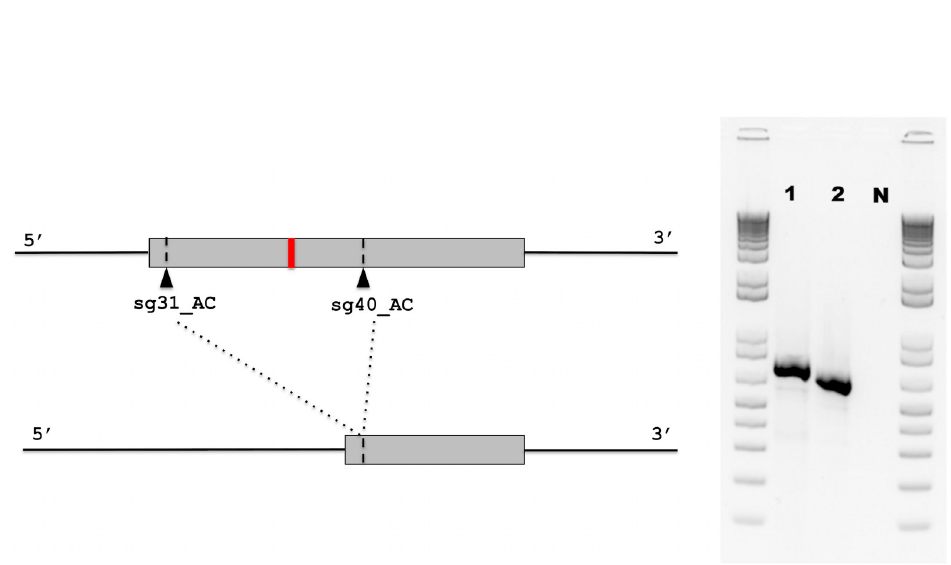
Fig 10. CRISPR Cas9 guide RNA design. Position of selected guide RNA in the second exon of SYNGR2 relative to the SYNGR2 p . Arg63Cys polymorphism resulting in a 106 bp deletion in the E1 edited clone (2) compared to wildtype PK15 (1) observed by agarose gel